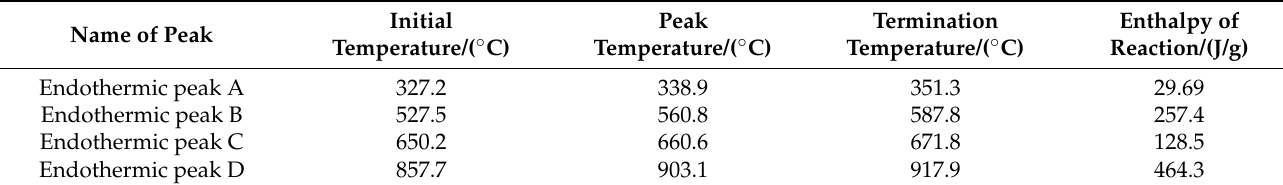
Figure 18. TG/DSC curve of Al/PTFE Composite. A-D: Endothermic peaks. Table 17. Parameters of peak A, B, C and D on DSC curve of Al/PTFE